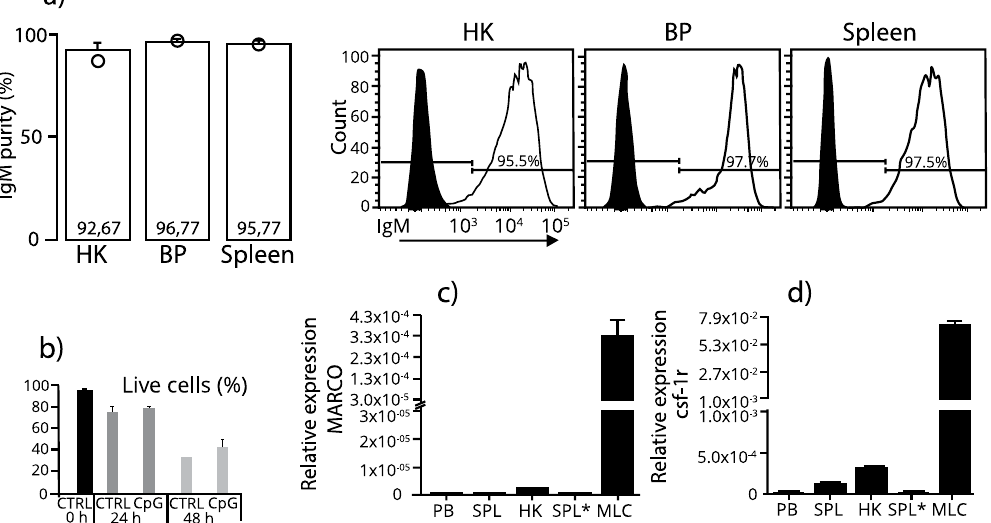
Figure 2. Purity and viability of IgM + B cells sorted by magnetic activated cell sorting (MACS). ( a ) Upon sorting, the mean percentages of IgM + cells from HK, PB and spleen (n = 3 for each tissue) were analysed by flow cytometry. The circle ( ○ ) represents total percentage of viable cells before gating for IgM + events. Histogram represents one representative individual for each tissue, where IgM + events are presented by the transparent peak and non-stained events by the black peak. ( b ) Viability of IgM + cells kept in culture with or without CpG for 0, 12 and 24 hours. ( c and d ) The relative expression of MARCO and csf-1r in MACS and FACS sorted IgM + cells, and in macrophage-like cells (MLC).